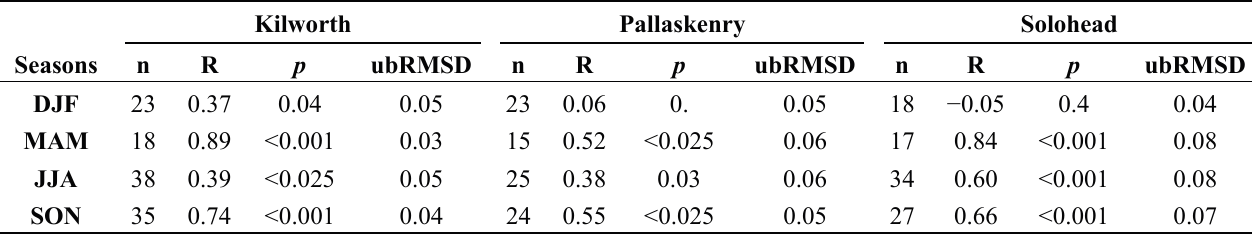
Table 5. Seasonal correlation (R) and unbiased RMSD (ubRMSD) between ASAR and in situ SM datasets (winter: DJF; spring: MAM; summer: JJA; autumn: SON). The number of available data (n) and the p -values ( p ) are also reported. Kilworth Pallaskenry